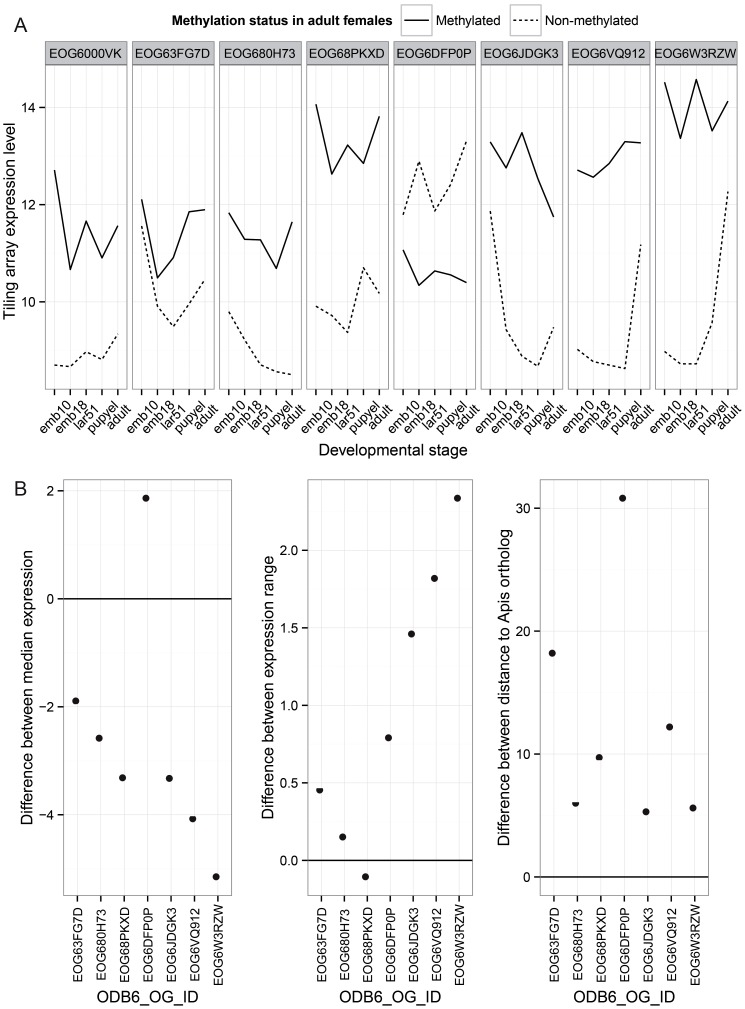
Paralog analysis.Differences between two paralogs that have changed in methylation status in the Nasonia lineage are shown. (A) Comparisons of expression pattern across developmental stages for duplicated genes in the Nasonia lineage where one gene is methylated (M) and the other lost methylation (N). These genes have 1∶1 orthologs in other hymenopteran species, and the ortholog is methylated in Apis. (B) Those paralogs that lost methylation show significant reductions in median expression level across development relative to the M paralog (N–M), significant increases in the range of expression level (N–M), and significantly greater divergence from the Apis ortholog (N–M).